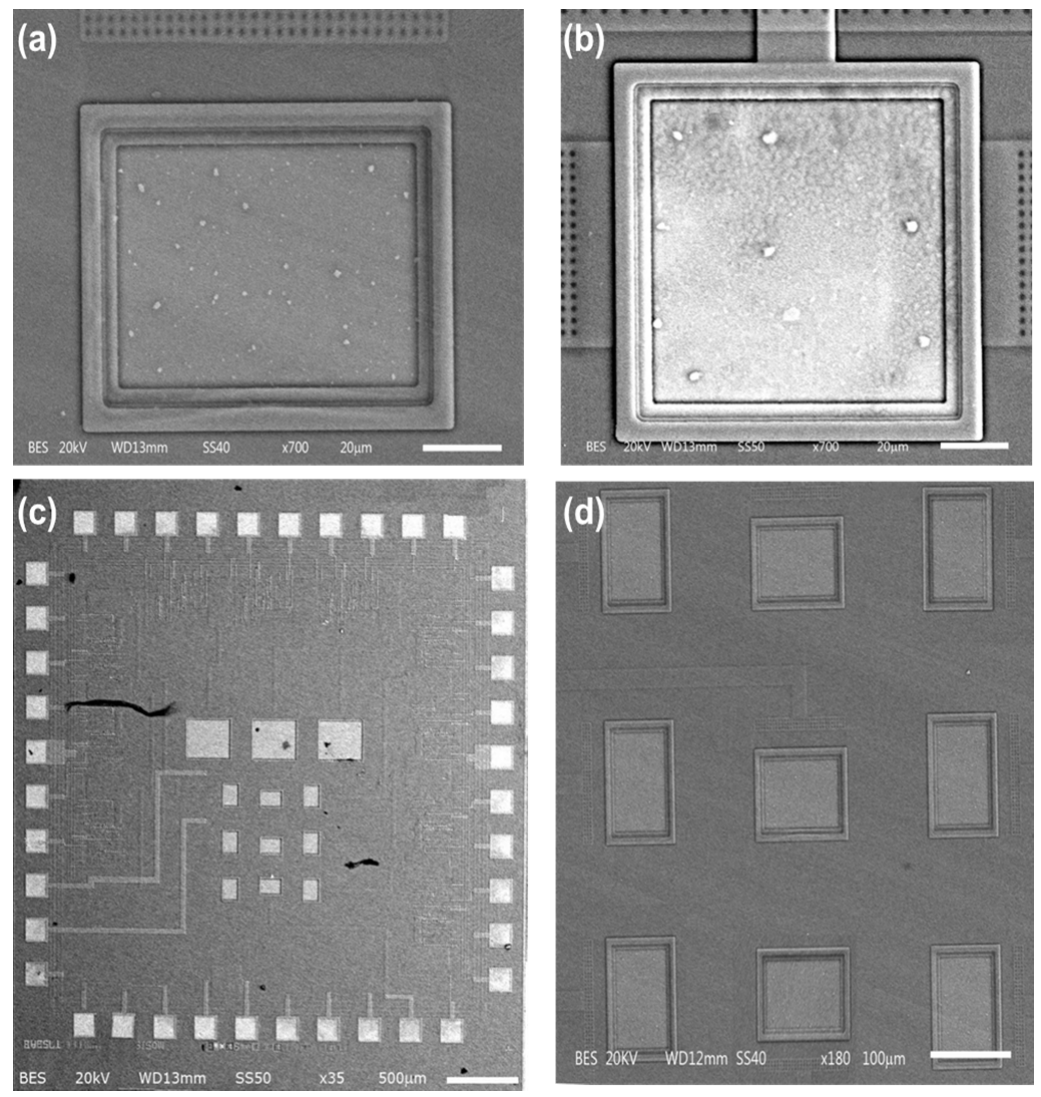
Figure 9. SEM images of the CMOS post-process, which were obtained (a) microelectrode of the pMEA, (b) power supply pad without damage, (c) chip after of the CMOS post- process and (d) the released pMEA through the CMOS post-process.